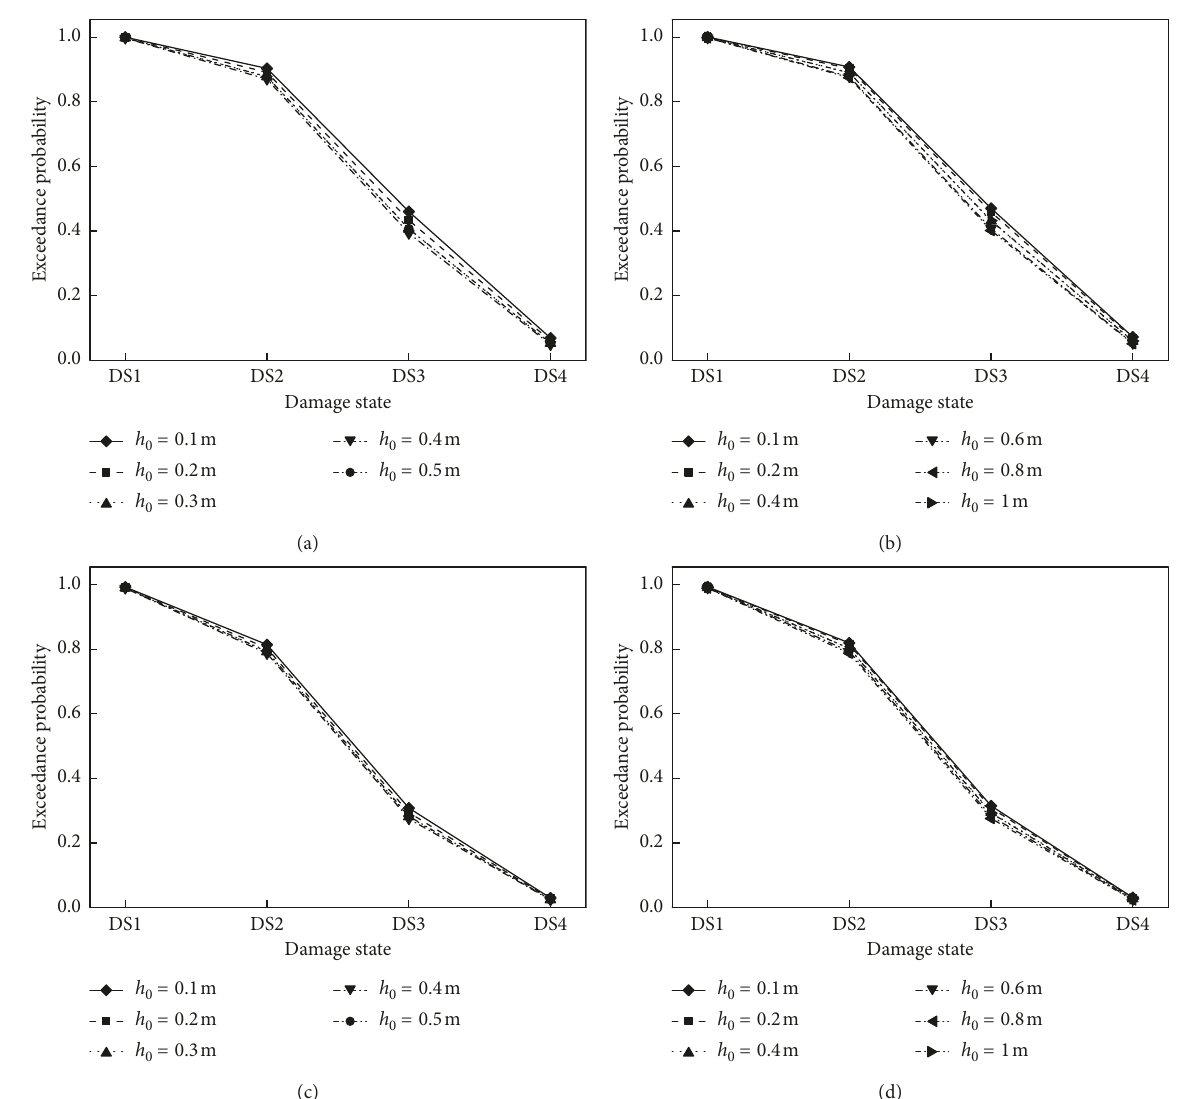
Figure 8: Structural peak relative displacement when K 100kN/m with different damping constant, PGA (cid:31) DS1, DS2, DS3, and DS4 are defined by the structural peak relative displacement in Table 2). (a) μ 0 1 , h . 0m, C 0.005, r 0.0 m 50kN s/m. (c) μ 0 C 50kN s/m. (b) μ 0 1 (cid:31) 1 (cid:31) (cid:31) (cid:31) · (cid:31) · 1 , h . 0m, C r 0.0m 100kN − 1 (cid:31) 1 (cid:31) (cid:31) · −